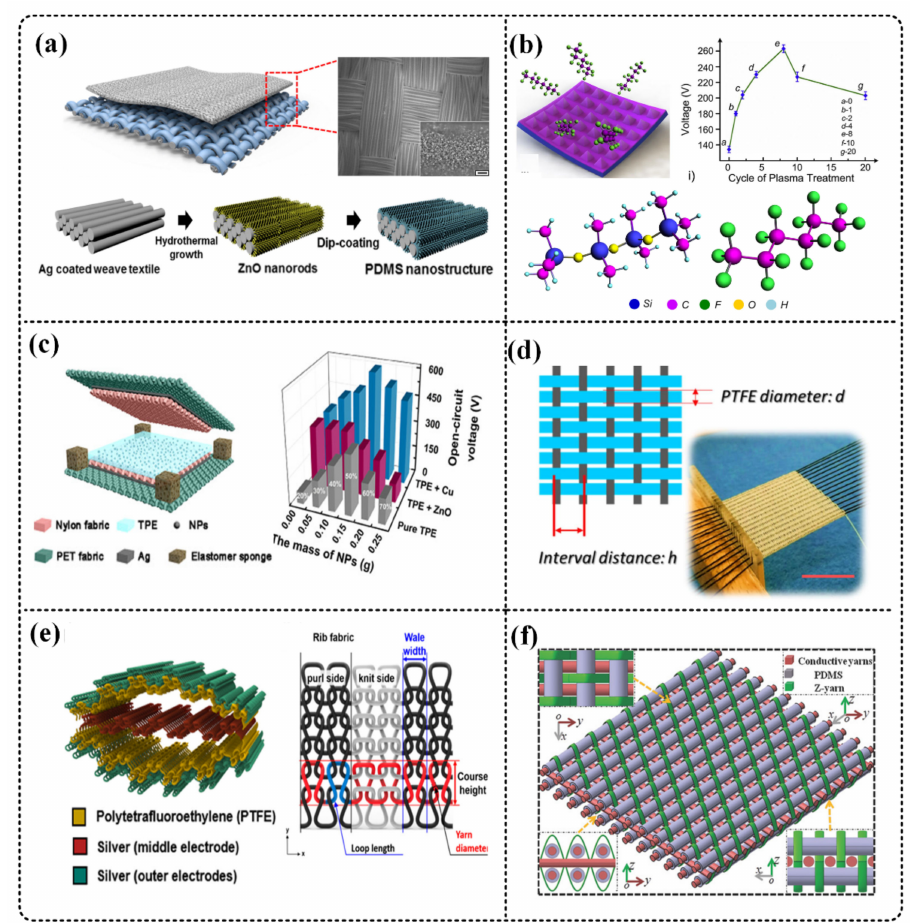
Figure 3. Methods to improve the electrical output of T-TENG. ( a ) Seung et al. perform nanopatterning on PDMS. Reproduced with permission from American Chemical Society (2015) [75]. ( b ) Zhang et al. used a single-step fluorocarbon plasma Table 2013. [79]. ( c ) Zhang et al. doped Cu nanoparticles into thermoplastic elastomer (TPE) composite fabrics, and the TENG made by them increased the output by 1.5 times. Reproduced with permission from American Chemical Society (2018) [81]. ( d ) Chen et al. studied the influence of the spacing between carbon wires and the line width of PTFE on the electrical output performance of TENG. Reproduced with permission from Elsevier (2018) [83]. ( e ) Kwak et al. used double-sided knitting and rib knitting to increase the electrical output of TENG. Reproduced with permission from American Chemical Society (2017) [84]. ( f ) Dong et al. used 3D structure design to improve TENG output performance. Reproduced with permission from Wiley (2017)